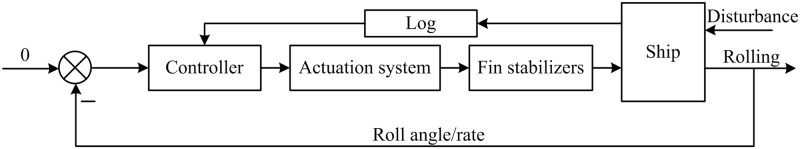
Diagram of roll reduction principle.